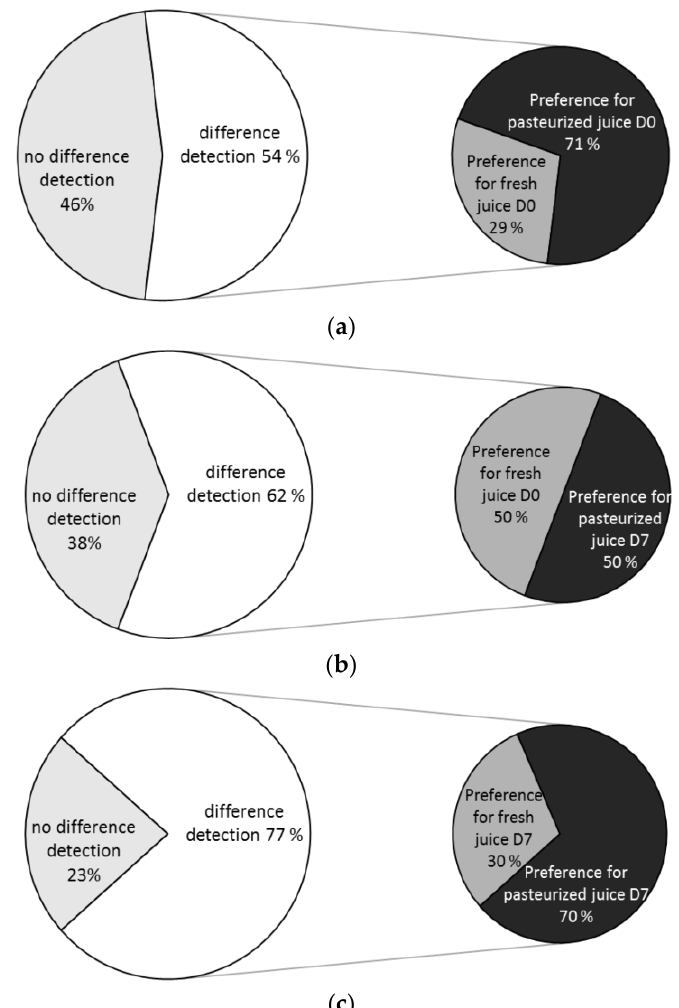
Figure 3. Proportion of panelist answers in triangle test comparison of ( a ) untreated juice at day 0 vs. pasteurized juice at day 0, ( b ) untreated juice at day 0 vs. pasteurized juice after 7 days of storage at 4 °C, ( c ) untreated juice after 7 days of storage at 4 °C vs. pasteurized juice after 7 days of storage at 4 °C.